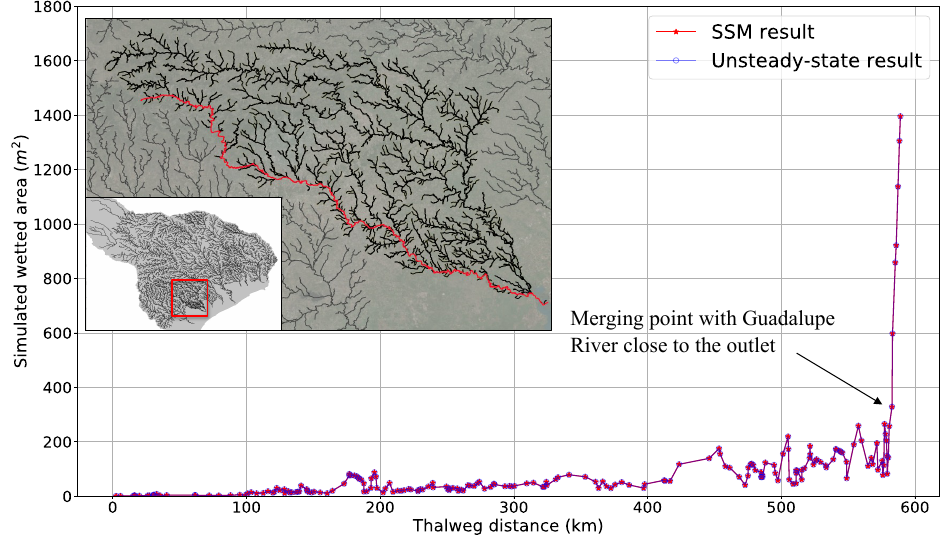
Figure 15. Comparison between steady (SSM) and unsteady simulated (full SVEs) wetted area in the main stem (shown in red) of the San Antonio